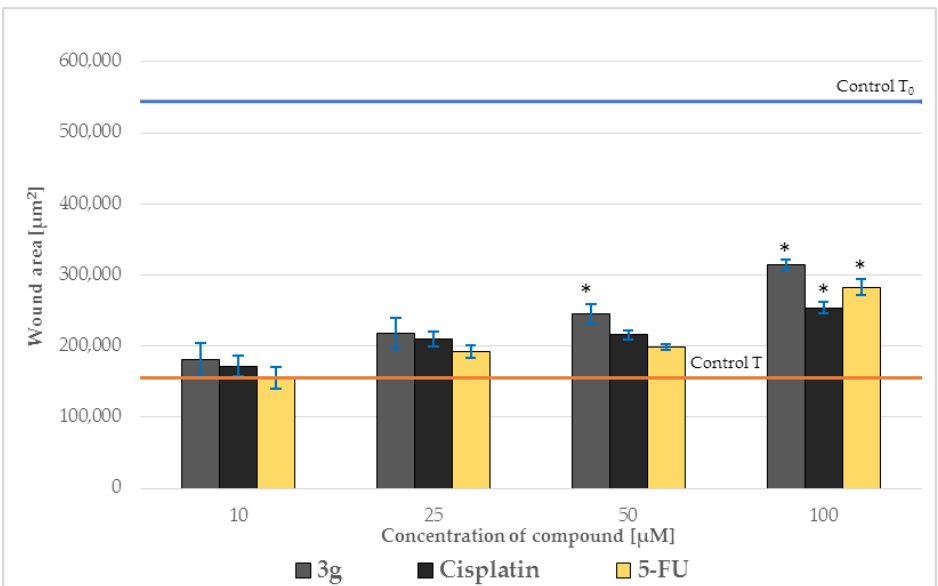
Figure 6. Effects of the tested compounds on the migration of cells in the scratch assay after 24 h of incubation for the HT29 cell line. Control T 0 is the width of the scratch, i.e., the wound at the beginning before the administration of the compound (T 0 = 544,366.45 ± 22,895.3). Control T is the width of the wound when no compound was administered (T = 155,558.2 ± 35,476.2). * p < 0.05—significant difference compared to the negative control.